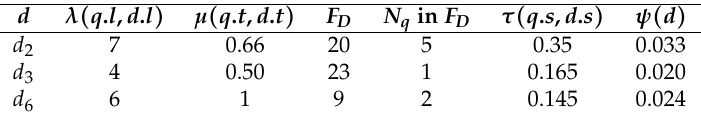
Table 2. Score computation of data objects.